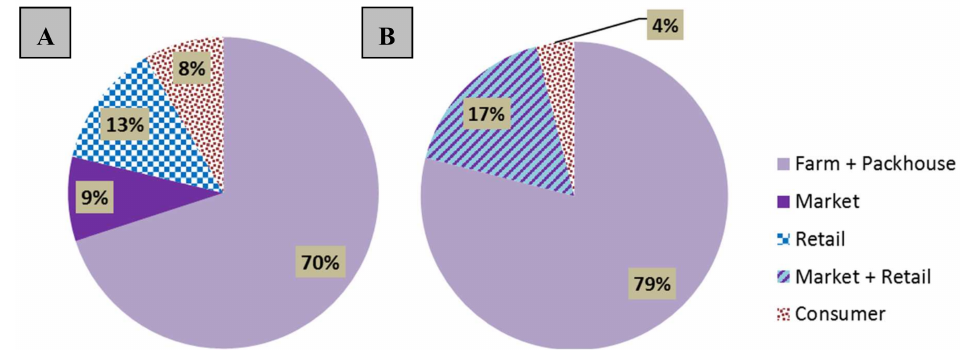
Figure 4. ( A ): Average percentages of total annual wastage of carrots, cabbage, beetroot, broccoli and lettuce produced on the Steenkoppies Aquifer at different stages along the supply chain from the field to the consumer; ( B ): Wastage of food along the supply chain in South Africa estimated by Oelofse and Nahman